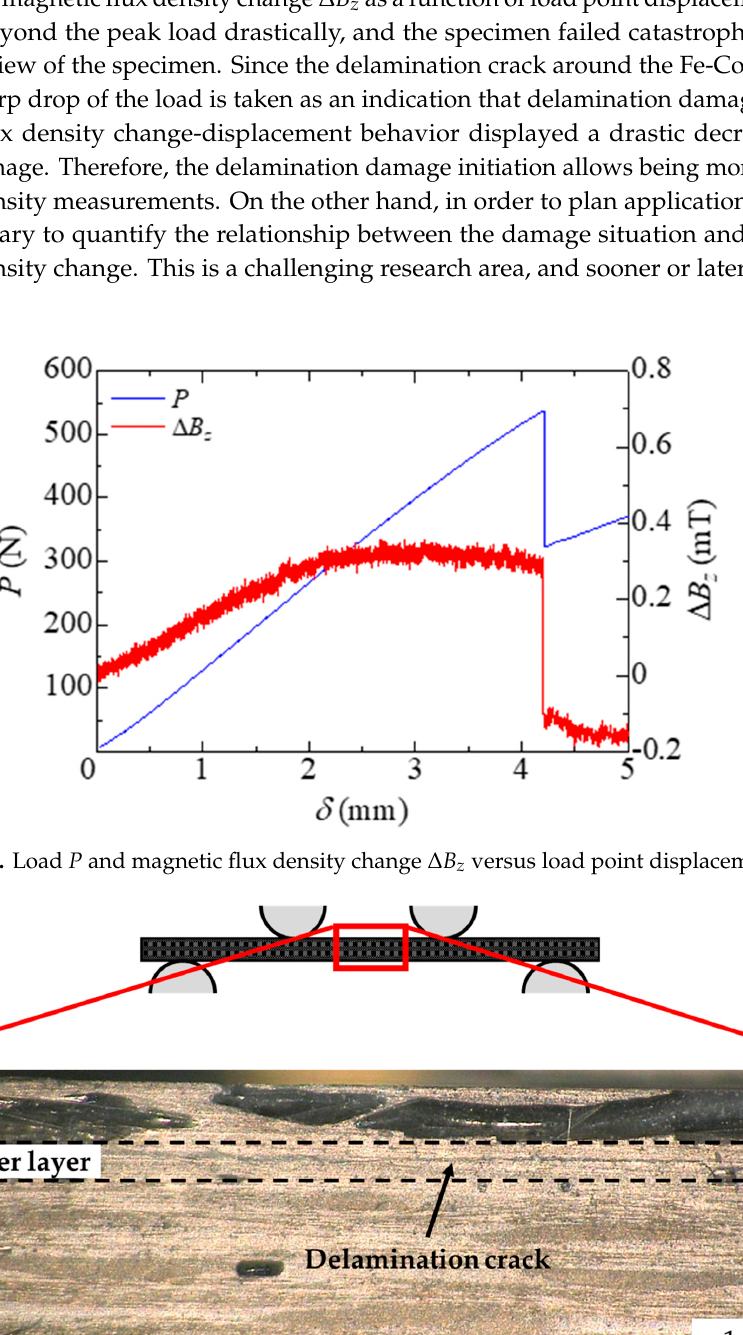
Figure 4. Load P and magnetic flux density change Δ B z versus time.